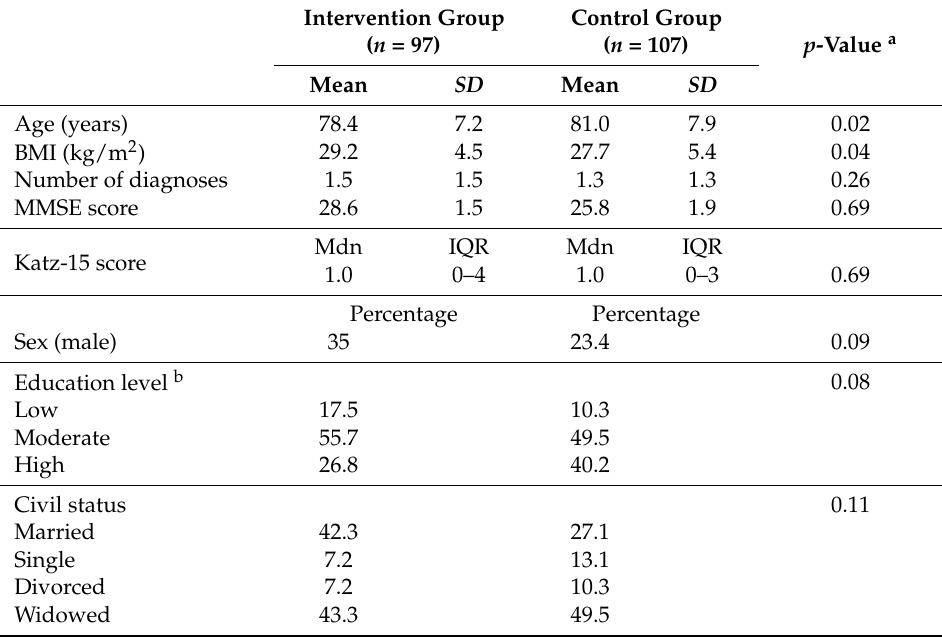
Table 2. Baseline characteristics of participants of the PhysioDom HDIM study.